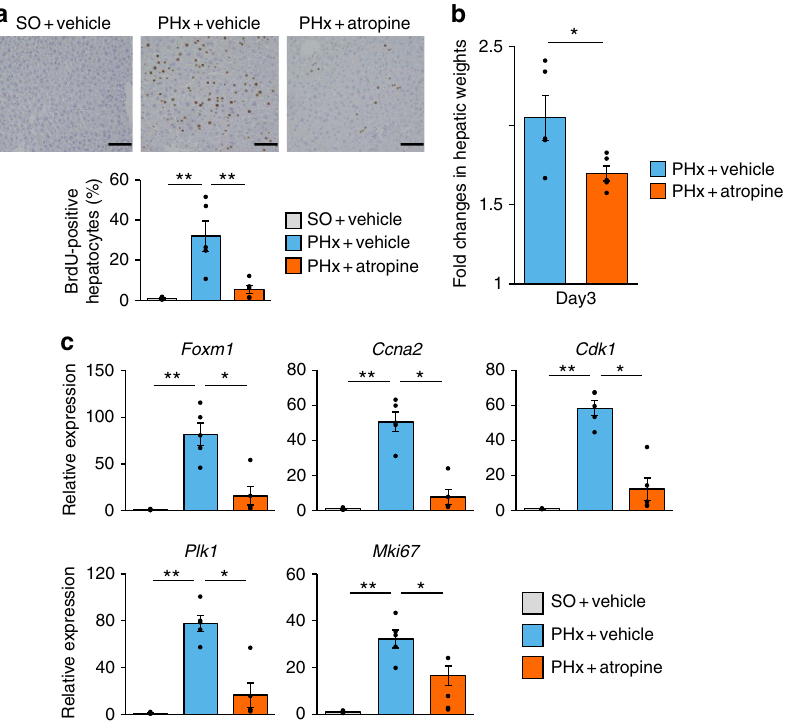
Fig. 4 Muscarinic signals are involved in acute liver regenerative responses after PHx. a (Upper panels) Representative images of liver sections immunostained for BrdU on day 2 after sham operation for PHx (SO) and PHx in vehicle-treated mice and after PHx in atropine-treated mice. Scale bars indicate 100 µ m. (Lower panel) BrdU-positive hepatocyte ratios in SO + vehicle mice ( n = 4), PHx + vehicle mice ( n = 5), and PHx + atropine mice ( n = 5). b Fold changes in hepatic weights 3 days after surgery in PHx + vehicle mice ( n = 5) and PHx + atropine mice ( n = 5). Hepatic weights were divided by those obtained immediately after surgery. c Relative expressions of Foxm1 , its target genes, and MKi67 in the liver 2 days after SO ( n = 4) and PHx ( n = 5) in vehicle-treated mice and PHx ( n = 5) in atropine-treated mice. * P < 0.05; ** P < 0.01 assessed by one-way ANOVA followed by Bonferroni ’ s post hoc test ( a and c ) or assessed by unpaired t test ( b ). n.s., not signi fi